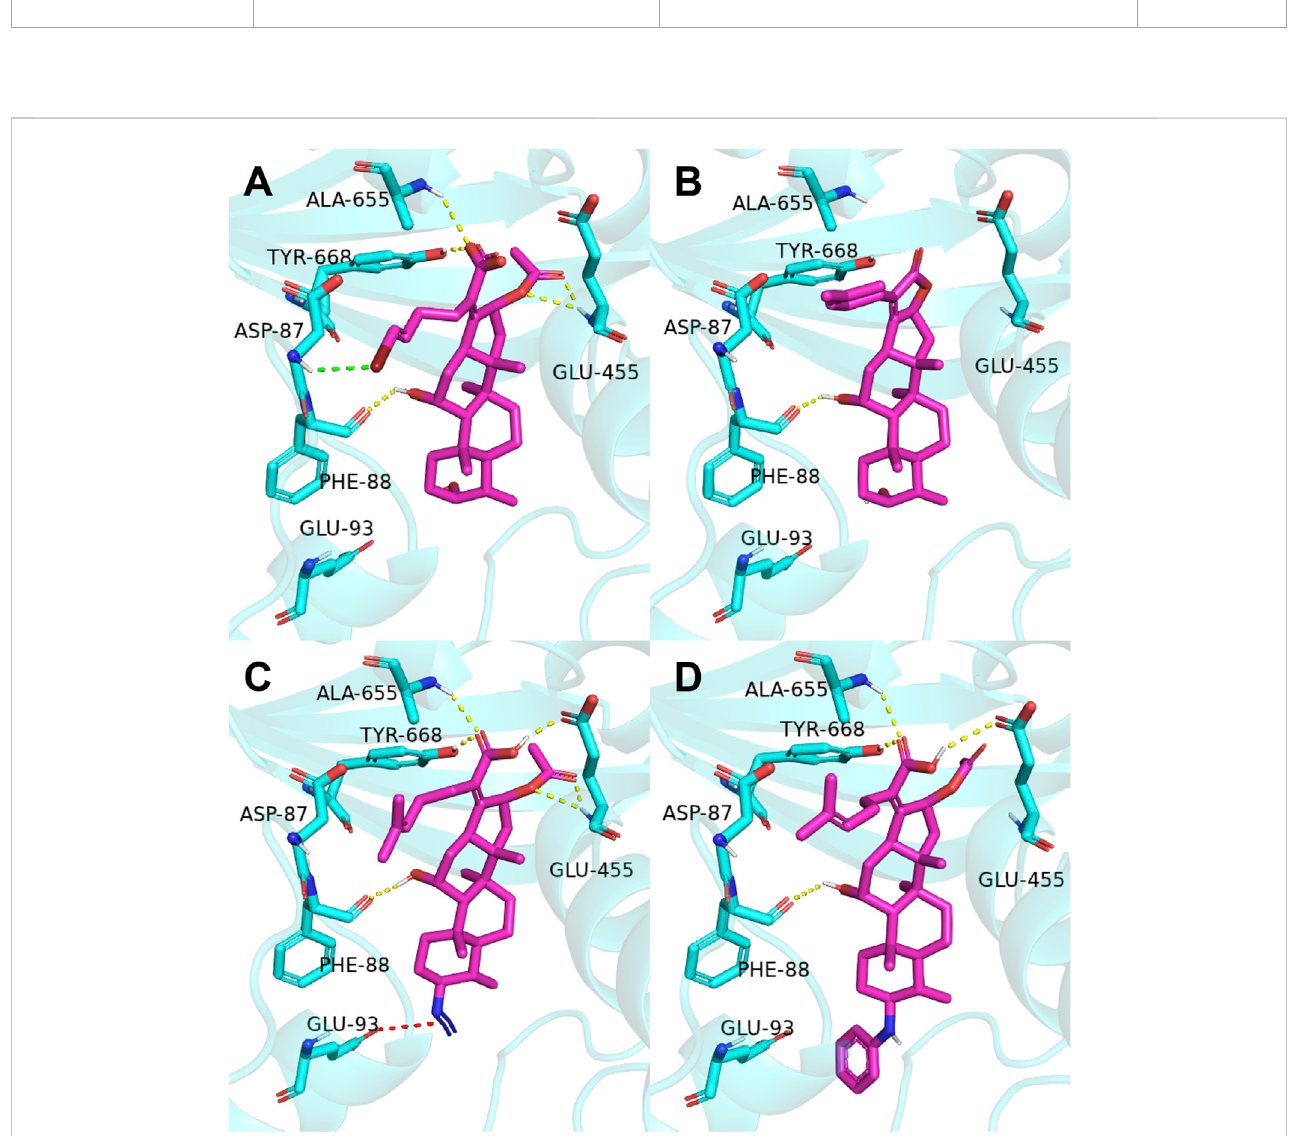
Binding mode of four derivatives in the S. aureus EF-G pocket: (A) FA-8 ; (B) FA-9 ; (C) FA-20; and (D) FA-22 . The relevant ligand molecules were colored by magenta, and the vital amino acid was colored by cyan. The red color dash indicated the salt bridge force; the yellow color dash indicated the hydrogen bond; and the green color indicated the halogen bond